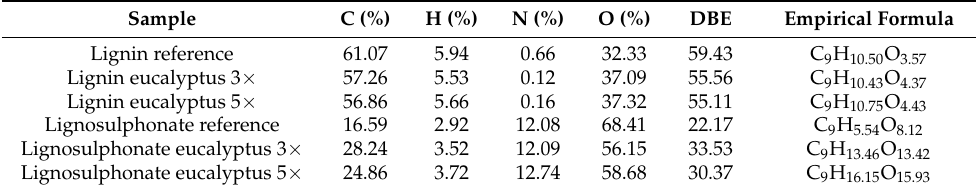
Table 7. Analysis C, H, O, N, and S of lignin and